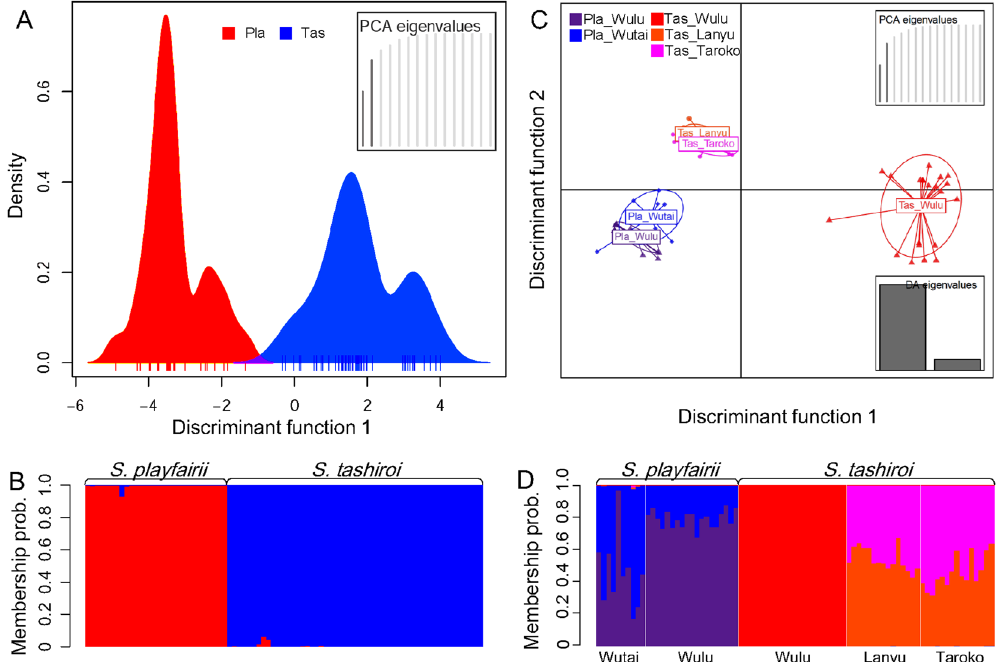
Figure 3. Genetic structure of the sampled populations as estimated by discriminant analysis of principal components (DAPC). The results show discriminable groups at the species level in the scatter plot ( A ), with small fractions of genetic admixture in the compoplot ( B ), and clusters of populations with partial overlap ( C ) and obvious admixture patterns between populations of each species, except the Wulu population of S . playfairii ( D